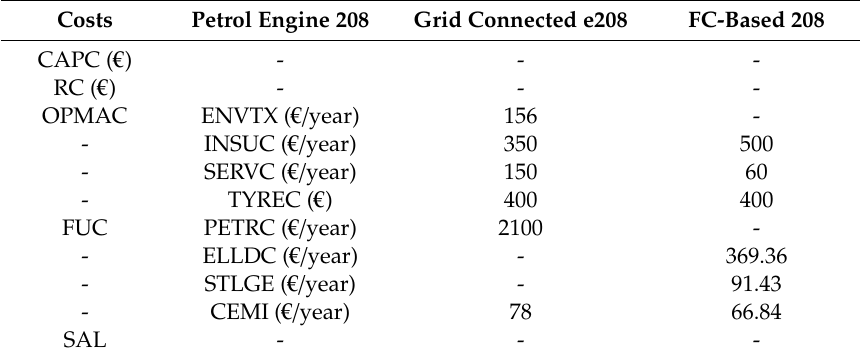
Table 3. Nominal cash